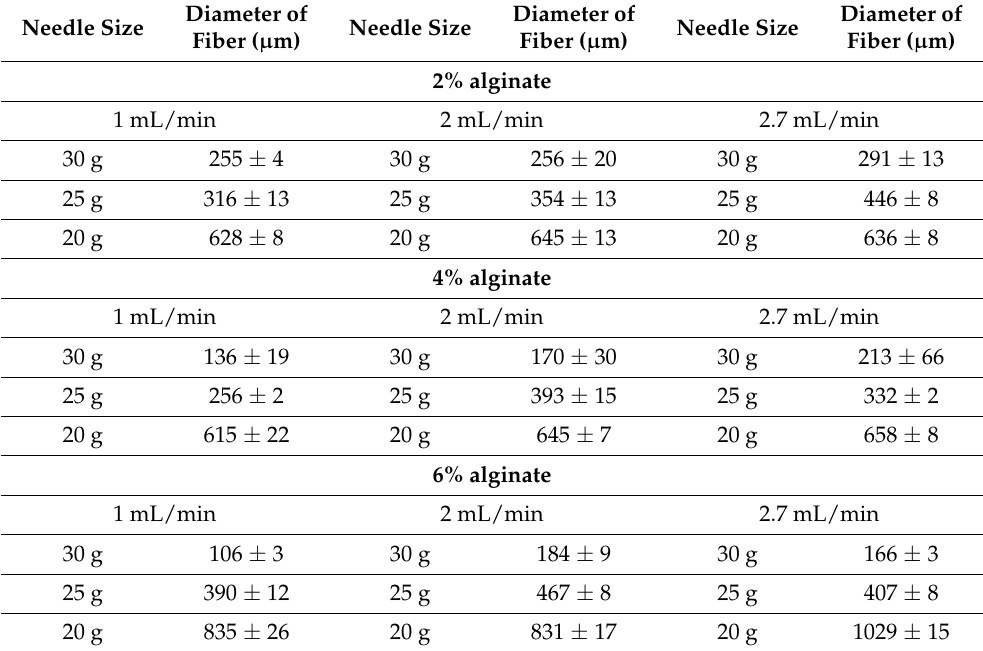
Table 1. Mean values and standard deviations of diameters of the cross-linked calcium alginate fibers generated via immersed microfluidic spinning using different volumetric flow rates of sodium alginate, different concentrations of sodium alginate solution, and the gauges of the needles. Diameter of Diameter of Diameter of Needle Size Needle Size Needle Size Fiber ( µ m) Fiber ( µ m)